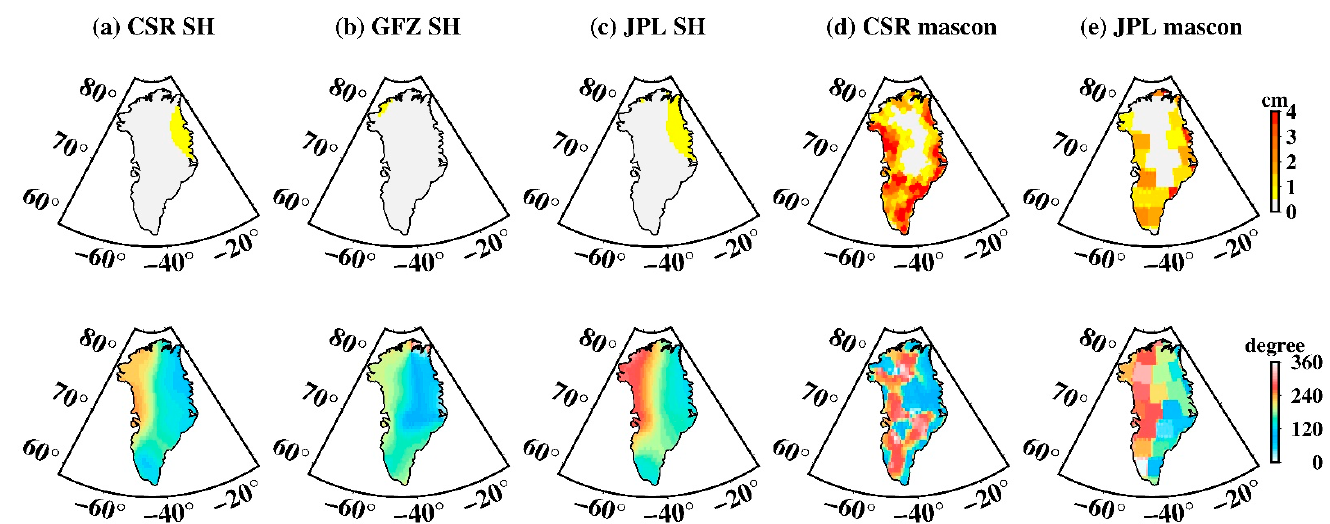
Figure 11. Spatial amplitude and the corresponding phase maps of S 1 tide aliasing over Greenland. ( a – e ) Estimated from CSR SH data, GFZ SH data, JPL SH data, CSR mascon data, and JPL mascon data, respectively. The upper row is the spatial amplitude and the bottom row is their corresponding phase.